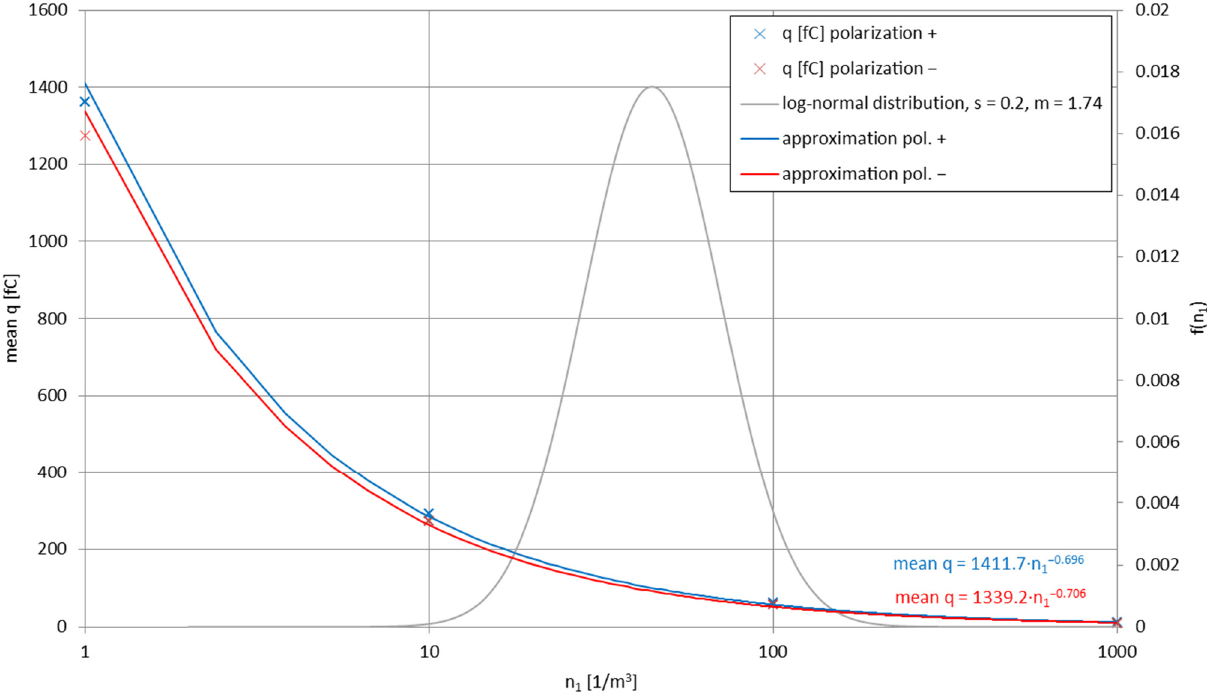
Figure 7. Calculated values of the mean electric charge per talc particle for different polarization cases, approximated as functions of the particles’ air concentration n 1 and plotted against the log-normal distribution, showing the most probable range of actual n 1 occurrence during the ex- periments.